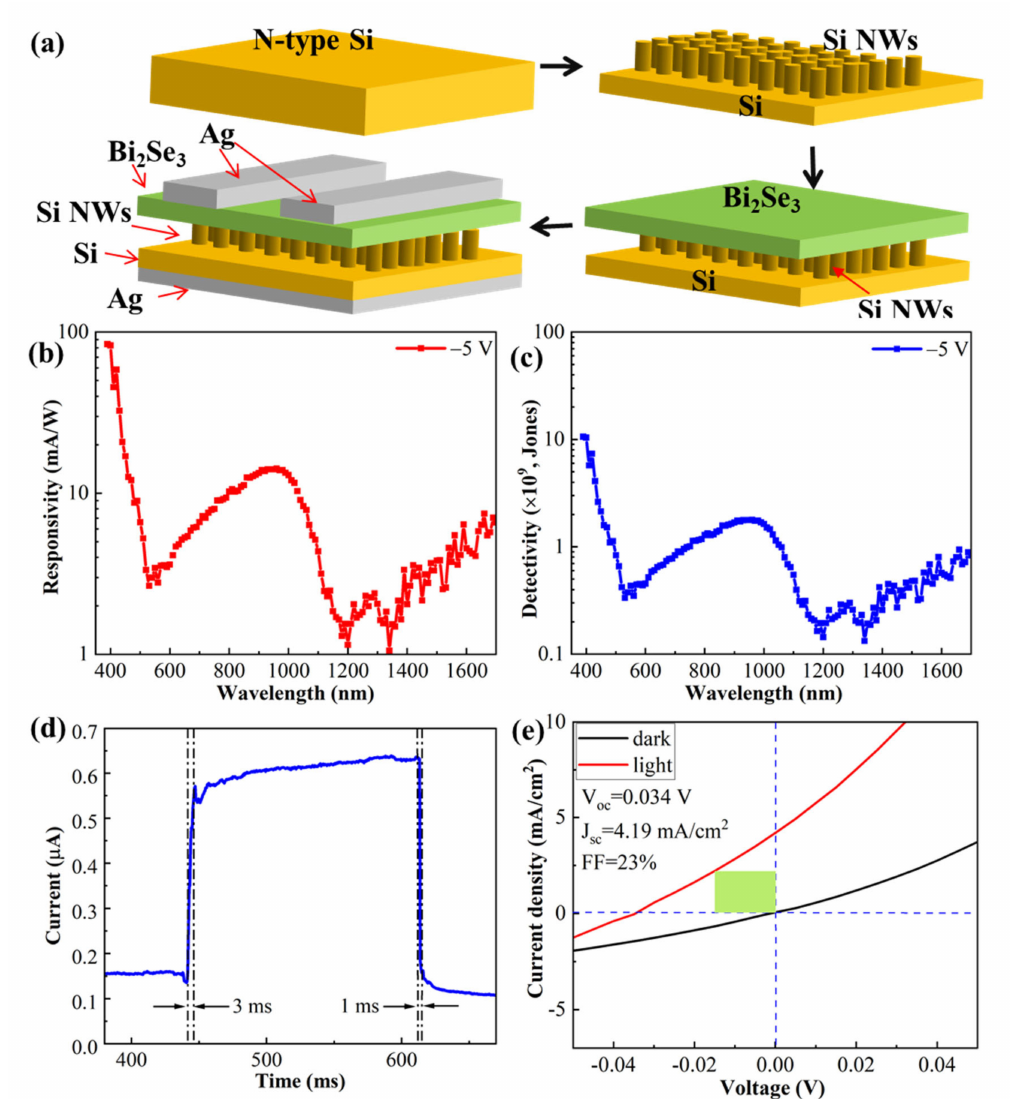
Figure 5. Characterization of n-Bi 2 Se 3 /p-Si photodetector: ( a ) its fabrication process; ( b ) its respon- sivity and ( c ) its detectivity at the wavelength range from 390 nm to 1700 nm; ( d ) its response times and ( e ) its photovoltaic behavior measured under a 980 nm laser illumination with a laser power of 0.6